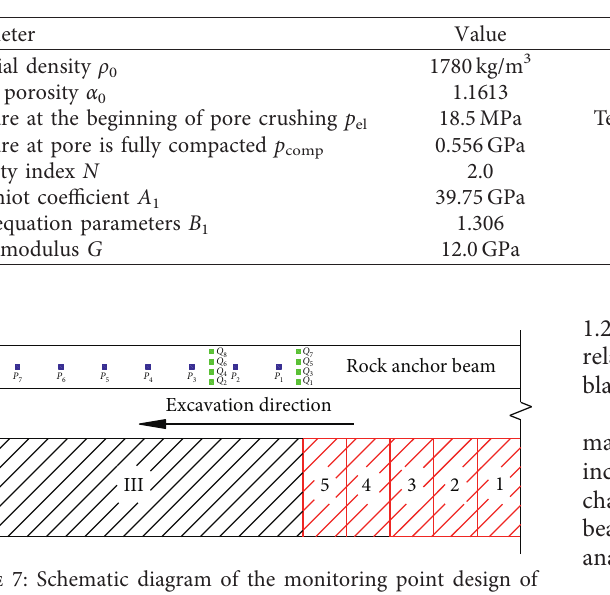
Table 2: Parameters of the RHT concrete model.